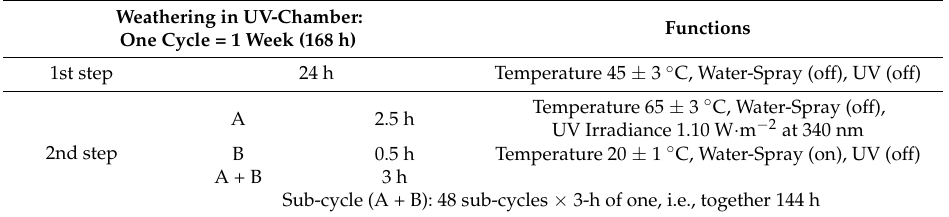
Table 3. One cycle of weathering in a UV-chamber according to modified EN 927-6